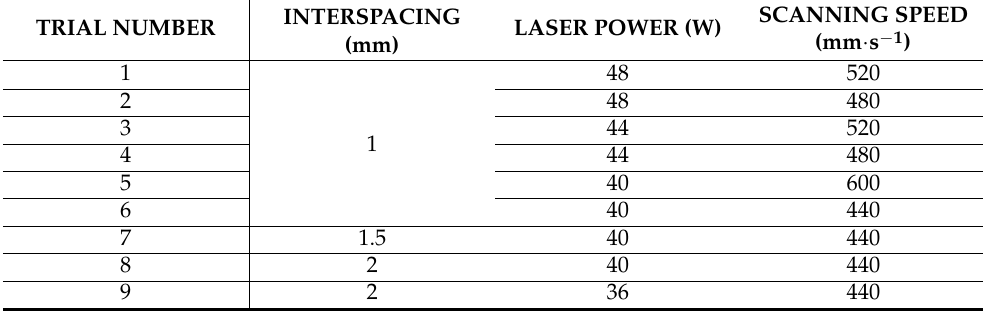
Table 1. Contact lenses processed under different laser conditions to engrave the couple-rings. SCANNING SPEED INTERSPACING TRIAL NUMBER LASER POWER (W) (mm · s − 1 (mm)